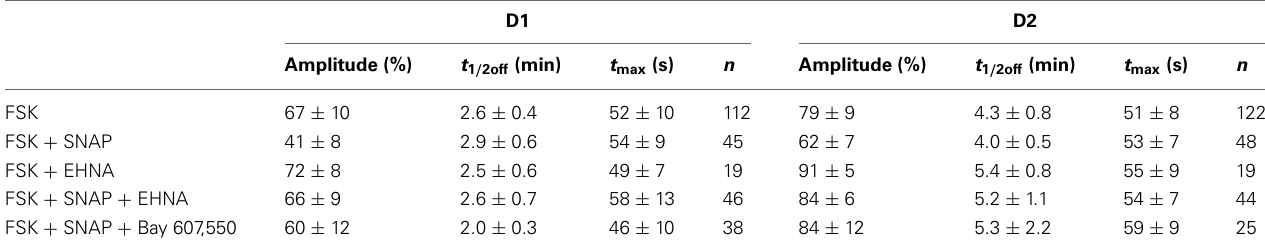
cAMP signals were measure in wide-field imaging with Epac-S H 150 biosensor during the application of a 10s pulse of Forskoline (FSK, 13 µ M) alone or in